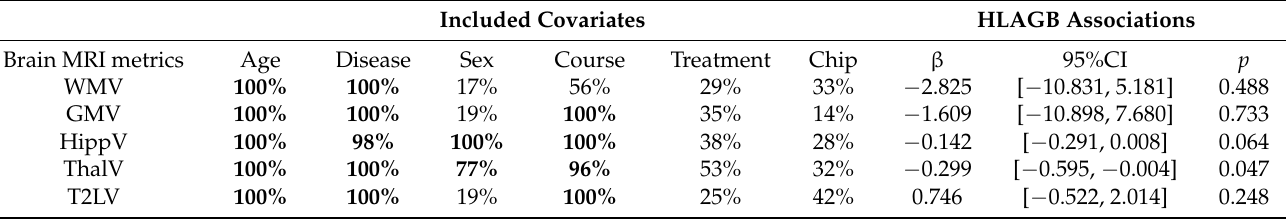
Table 2. Included covariates and HLAGB association